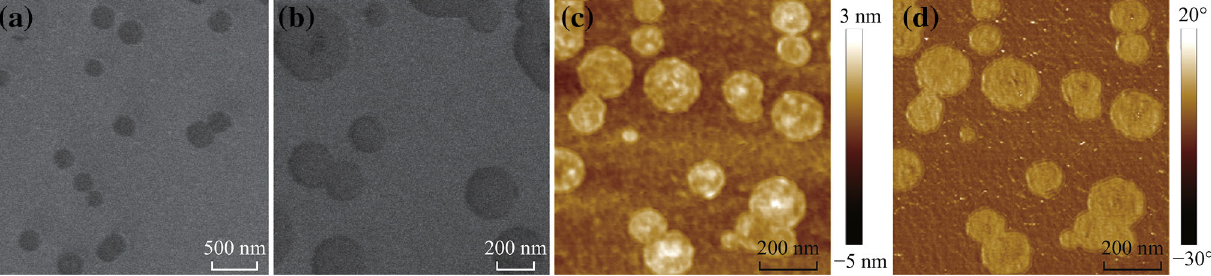
Fig. 2 a , b High-resolution SEM images of the graphene grains on silicon. c High-magnification AFM topography and d corresponding phase image of the graphene grains on